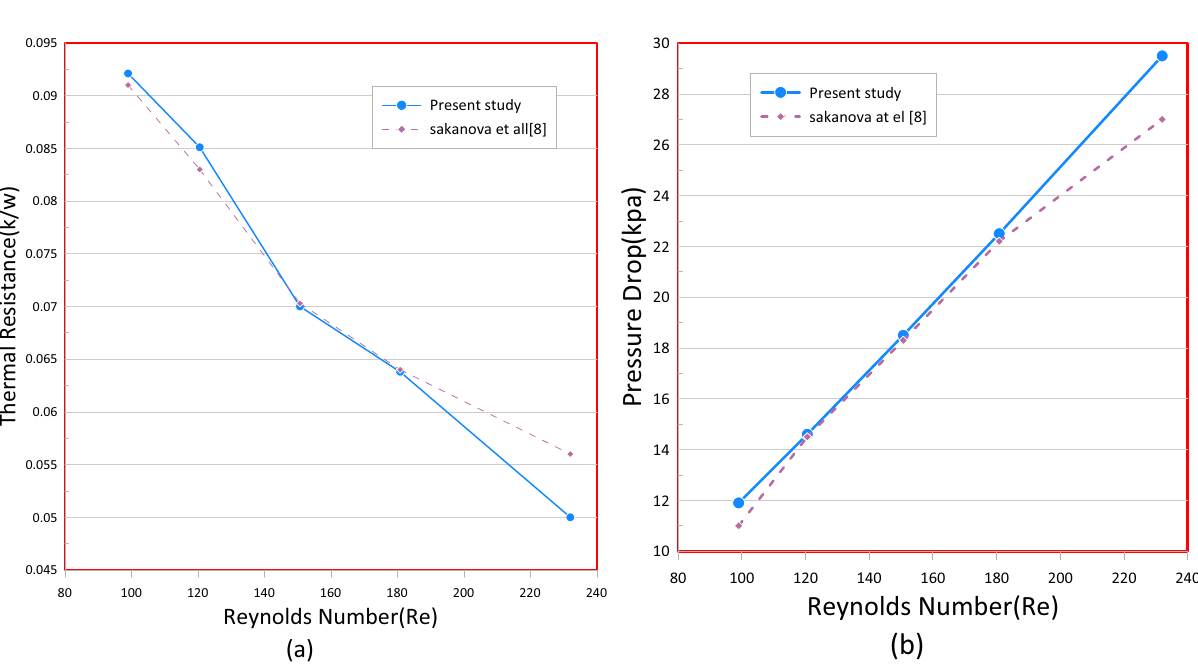
Figure 6. Comparison of the current investigation to Sakanova et al’s temperature distribution path through the rectangular channel.